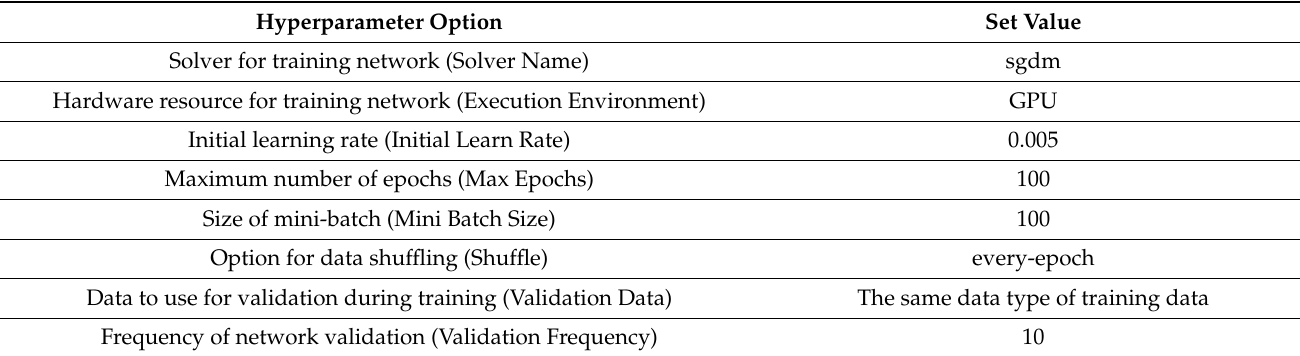
Table 1. Hyperparameters in CNN training period.